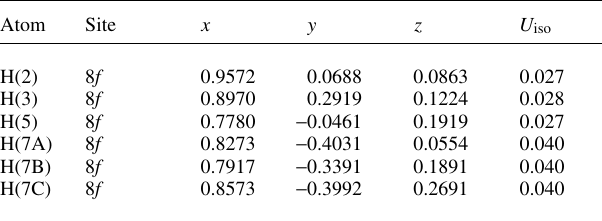
Table 2. Atomic coordinates and displacement parameters (in Å 2 )